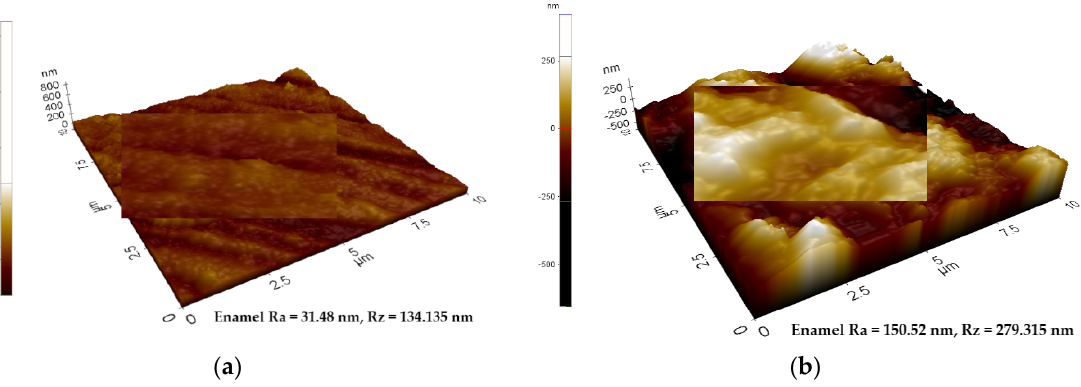
Figure 1. AFM image - Three-dimensional appearance of the enamel structure. The variability of the roughness profile can be observed at the enamel level. ( a ) X Scan Size 10 μ m, Y Scan Size 10 μ m, Ra = 31.48 nm, Rz = 134.135 nm; ( b ) X Scan Size 10 μ m, Y Scan Size 10 μ m, Ra = 150.52 nm, Rz = 279.315 nm.